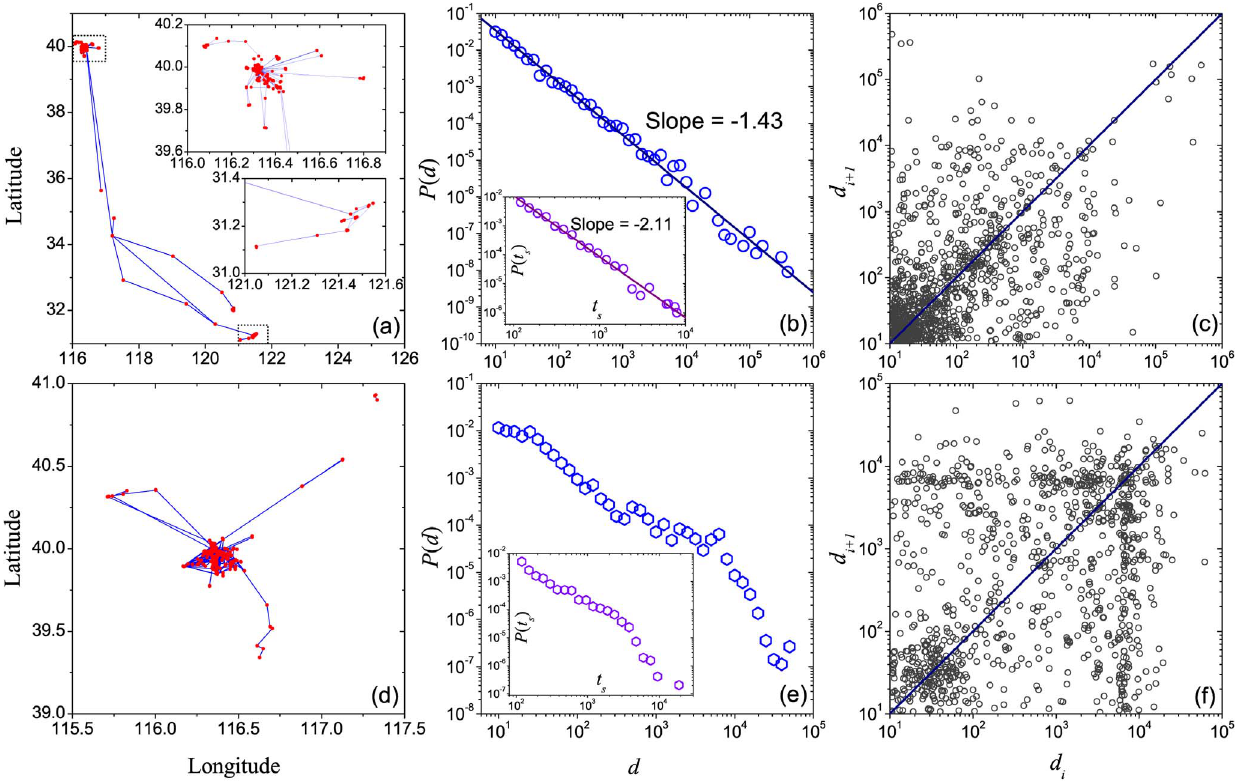
Figure 6. Mobility patterns for two typical users. Trajectories (a, d), displacement distributions P ( d ) (b, e), staying time distributions P ( t s ) (insets in (b, e)) and correlation patterns (c, f) of two typical individuals (upper and lower three panels for individual No. 9 and No. 22 respectively.